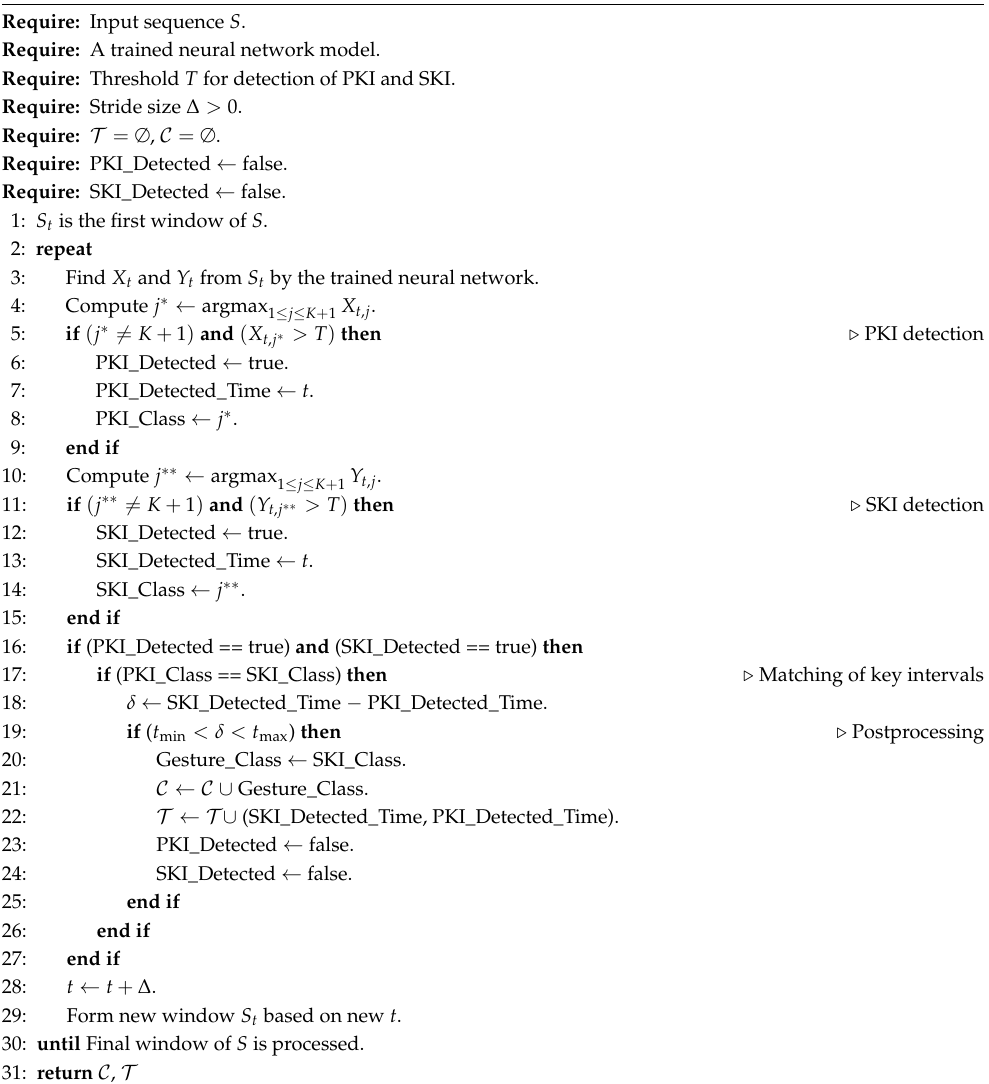
Algorithm 1 Proposed Gesture Inference